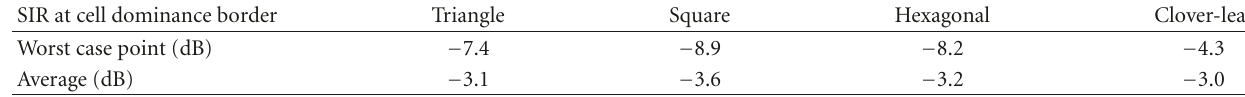
Table 3: Results of SIR analysis on cell dominance area border, slope 35dB/dec.